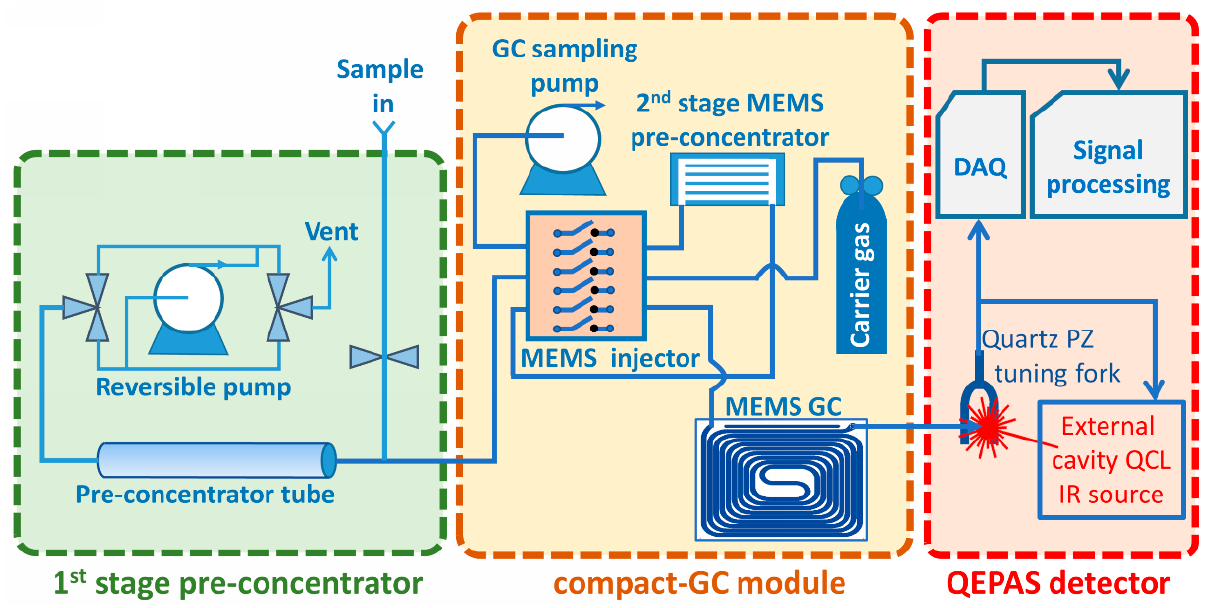
Figure 1. Sensing chain of the GC-QEPAS sensor upgraded for RISEN.